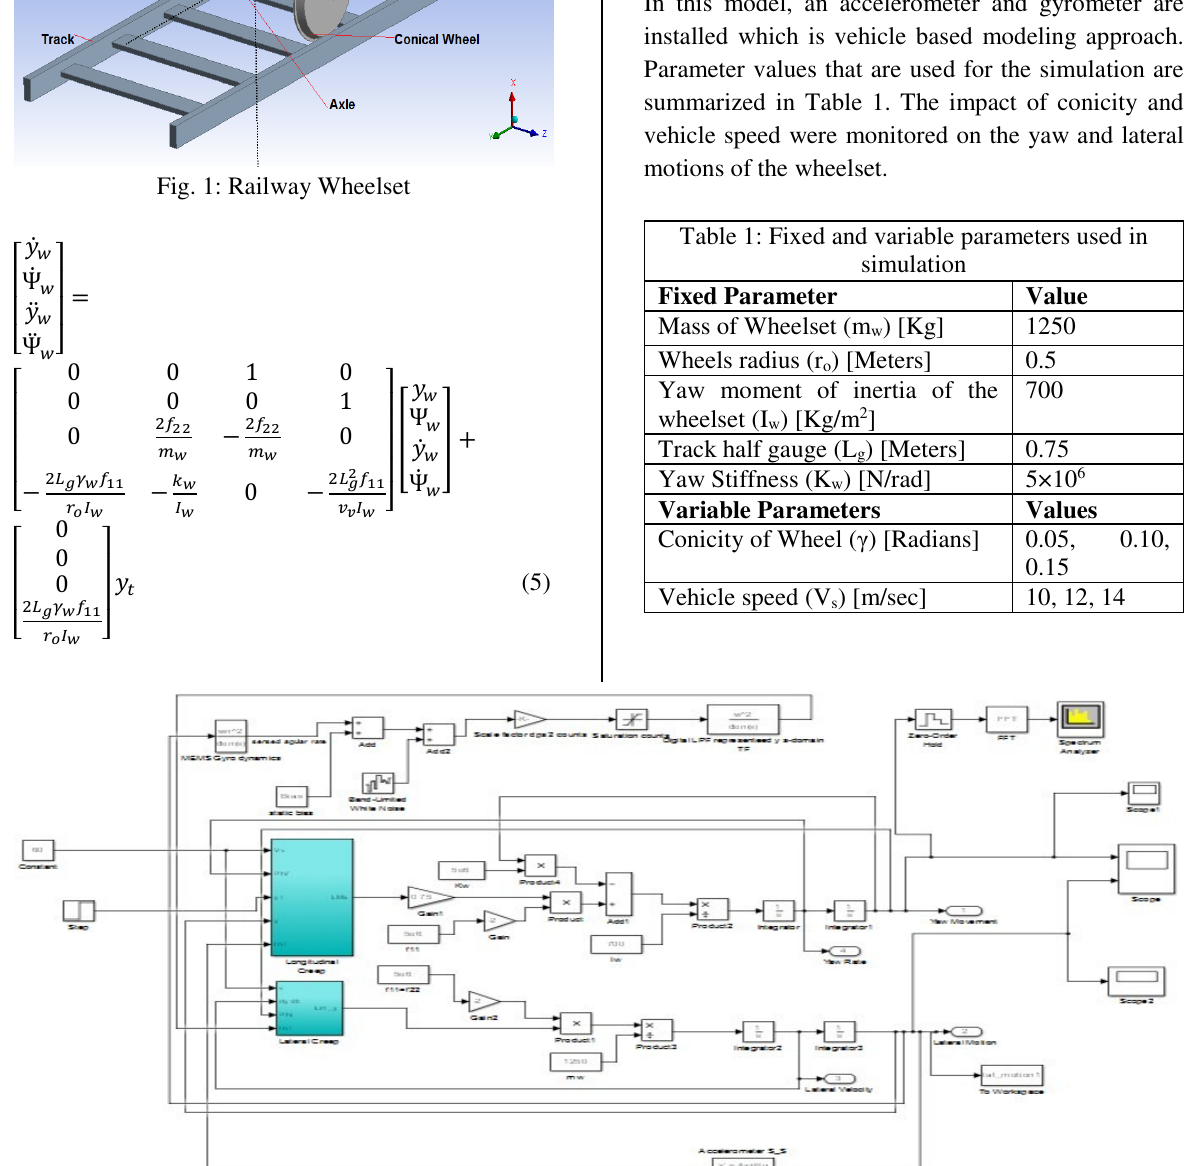
Fig. 1: Railway Wheelset